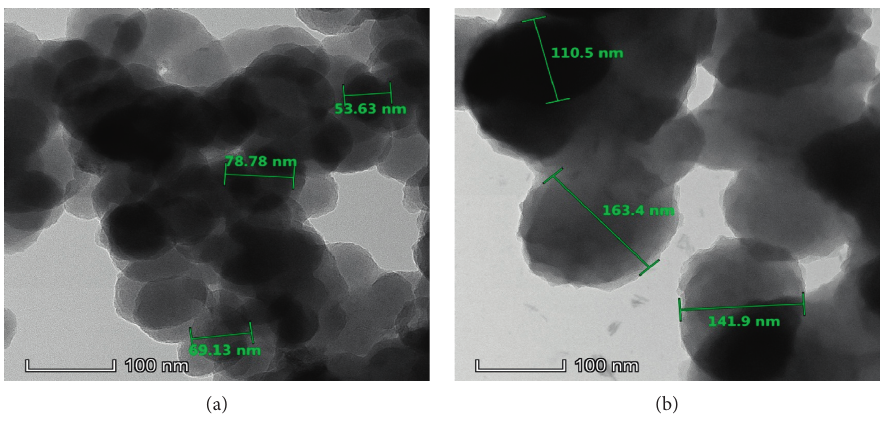
Figure 8: TEM images of PPy NPs (a) and 5 wt% PFFs nanocomposite